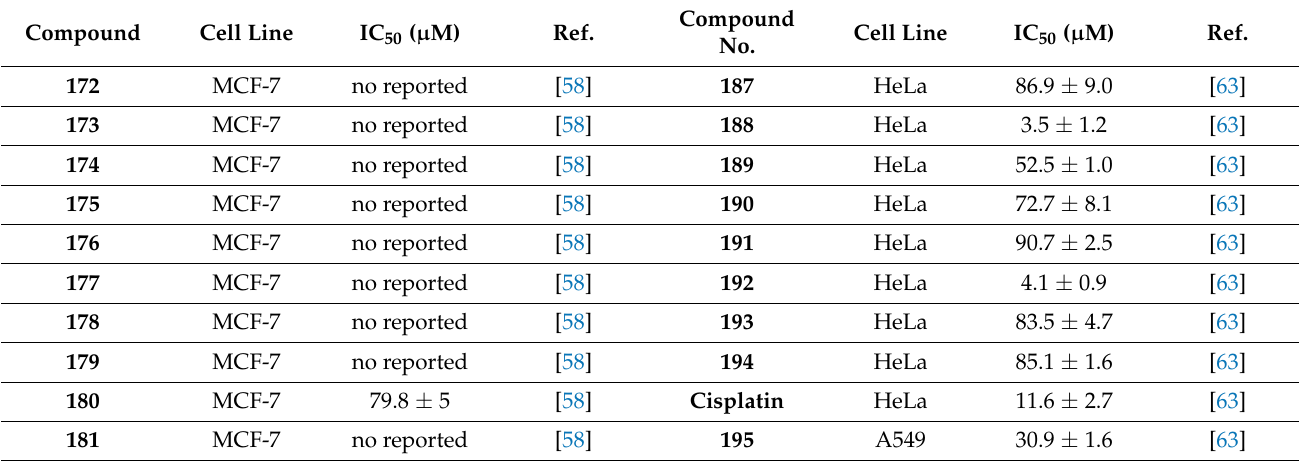
Table 2. Anticancer activity data of coumarin-derived imine–metal